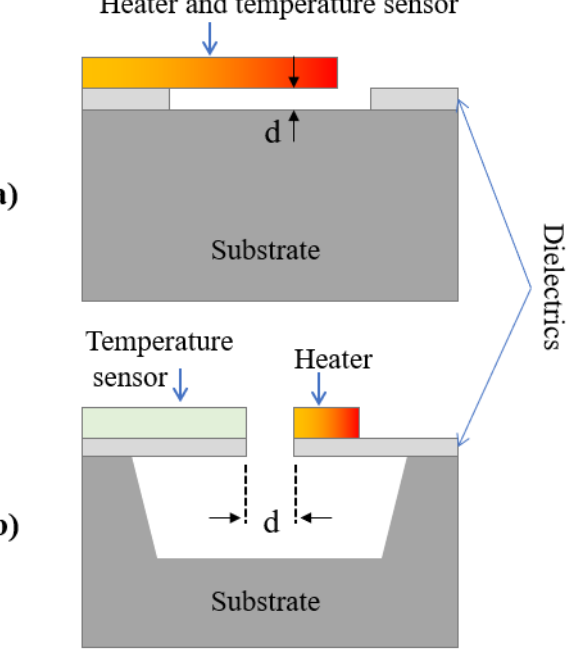
Figure 12. The structure of a micro-Pirani sensor with both heating methods that include ( a ) self- heating and ( b ) mutual heating.